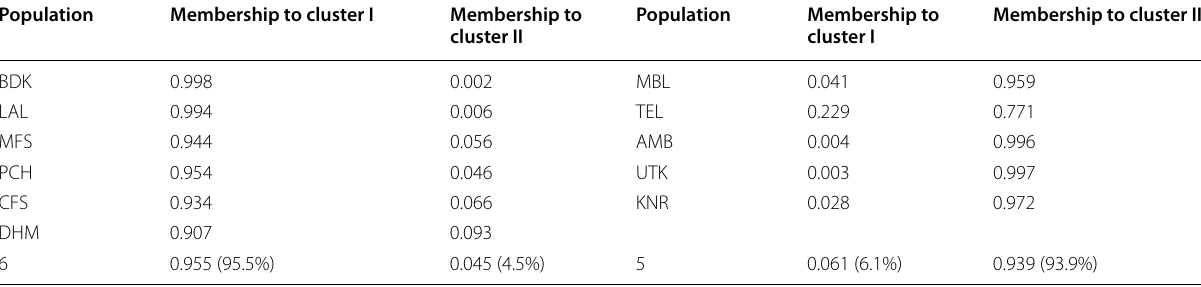
Population codes are as given in Table